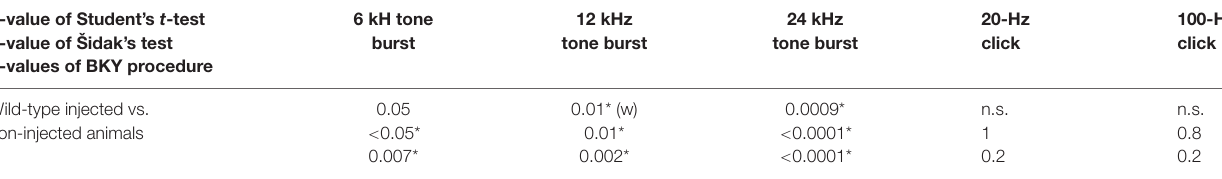
TABLE 1C | Statistical analysis of ABR thresholds in wild-type animals injected with the PHP.eB- Cabp2 with the respective controls. p -value of Student’s t -test p -value of Šidak’s test q -values of BKY